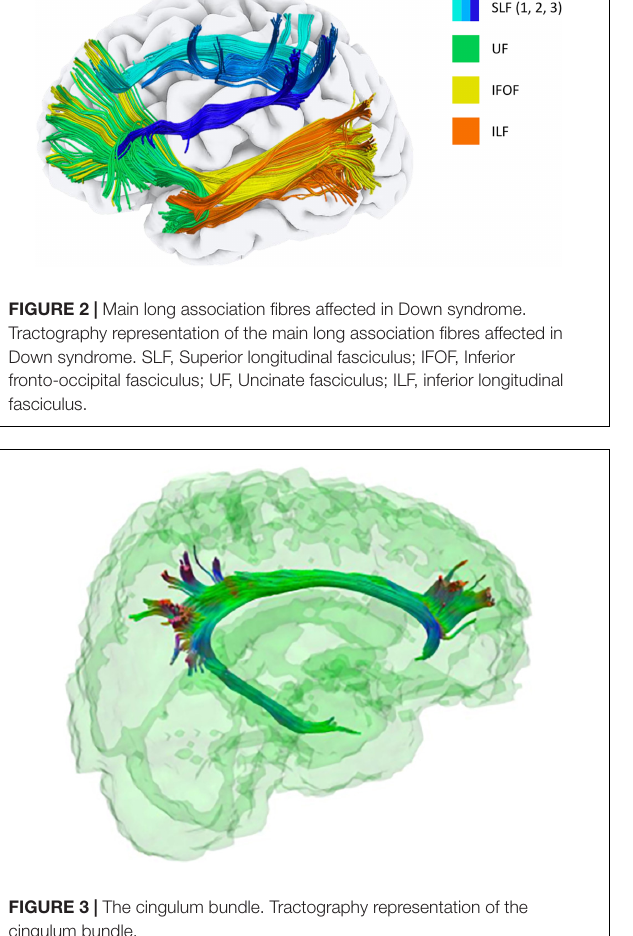
FIGURE 3 | The cingulum bundle. Tractography representation of the cingulum